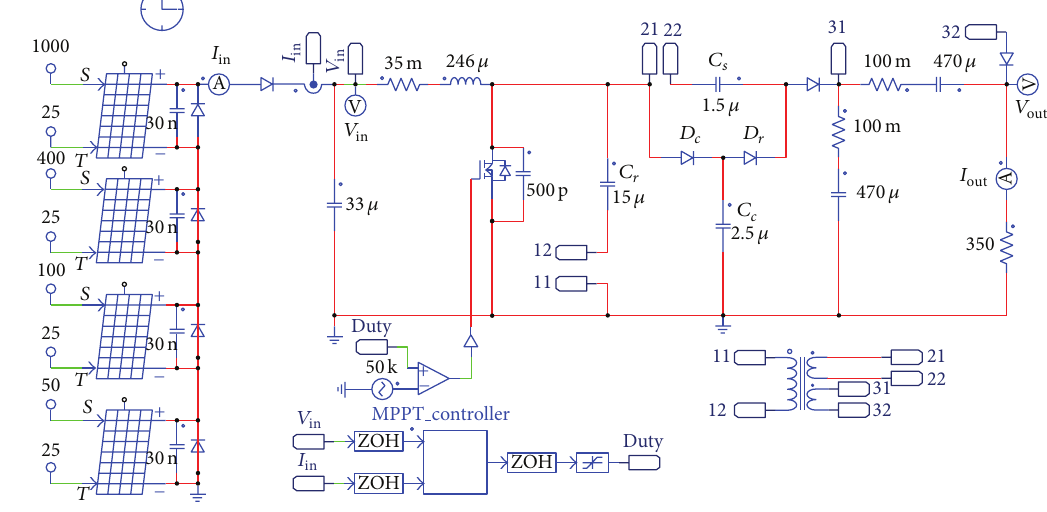
Figure 4: PSIM model blocks of the proposed PV system.